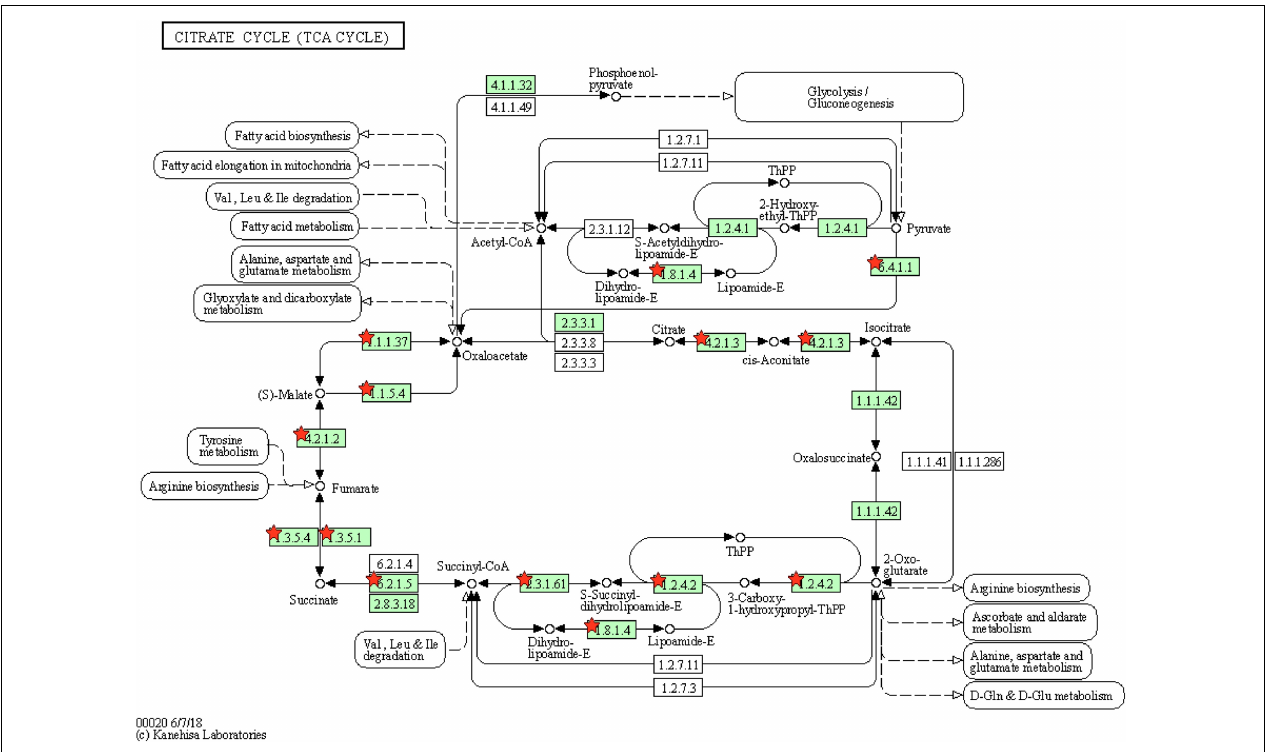
FIGURE 7 | Tricarboxylic acid cycle with genes enriching mutations. The red stars represent the genes with presence of mutations.